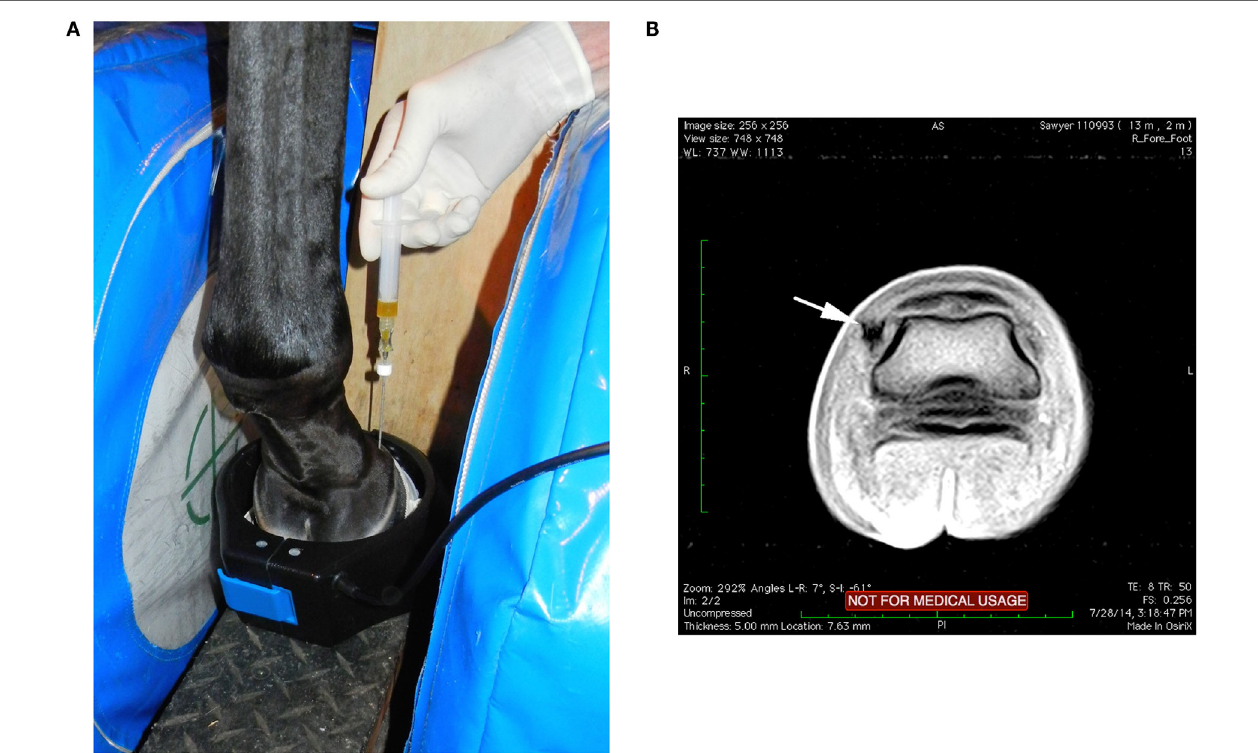
FigUre 1 | (a) With the horse’s left foot in the magnet the needle was placed using T1W-GE sequences to direct the needle into the medial DIJCL. (B) T1-weighted gradient echo sequence in this horse’s foot (medial is to the left) with focal hypointense signal (arrow) from the titanium needle placement in the